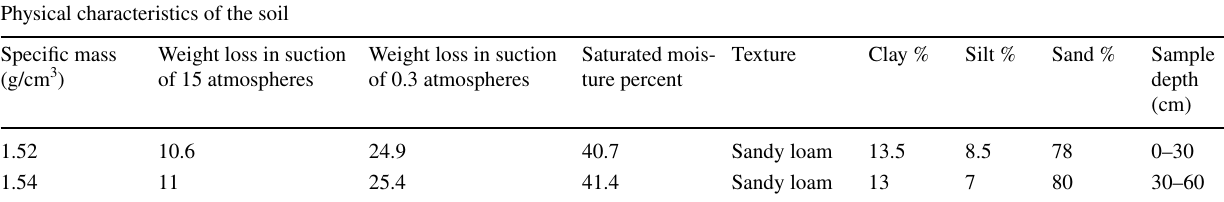
Table 2 Chemical composition of the studied field's soil